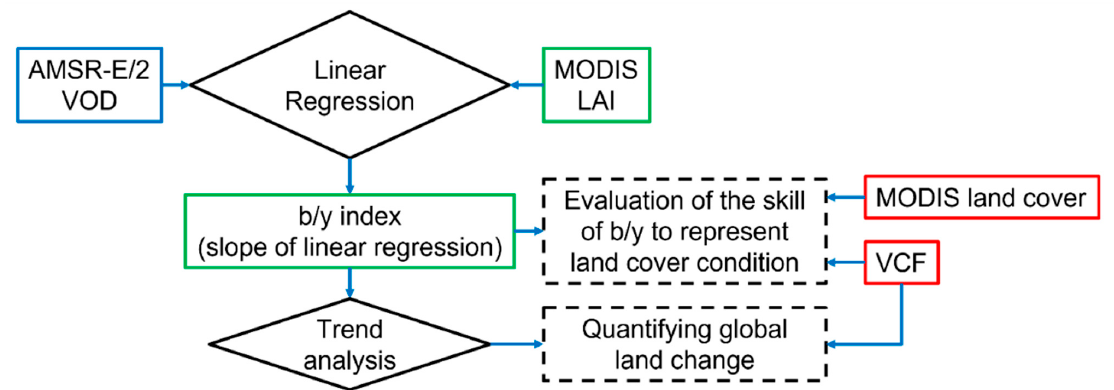
Figure 1. Flowchart of this study (see Section 2.2).